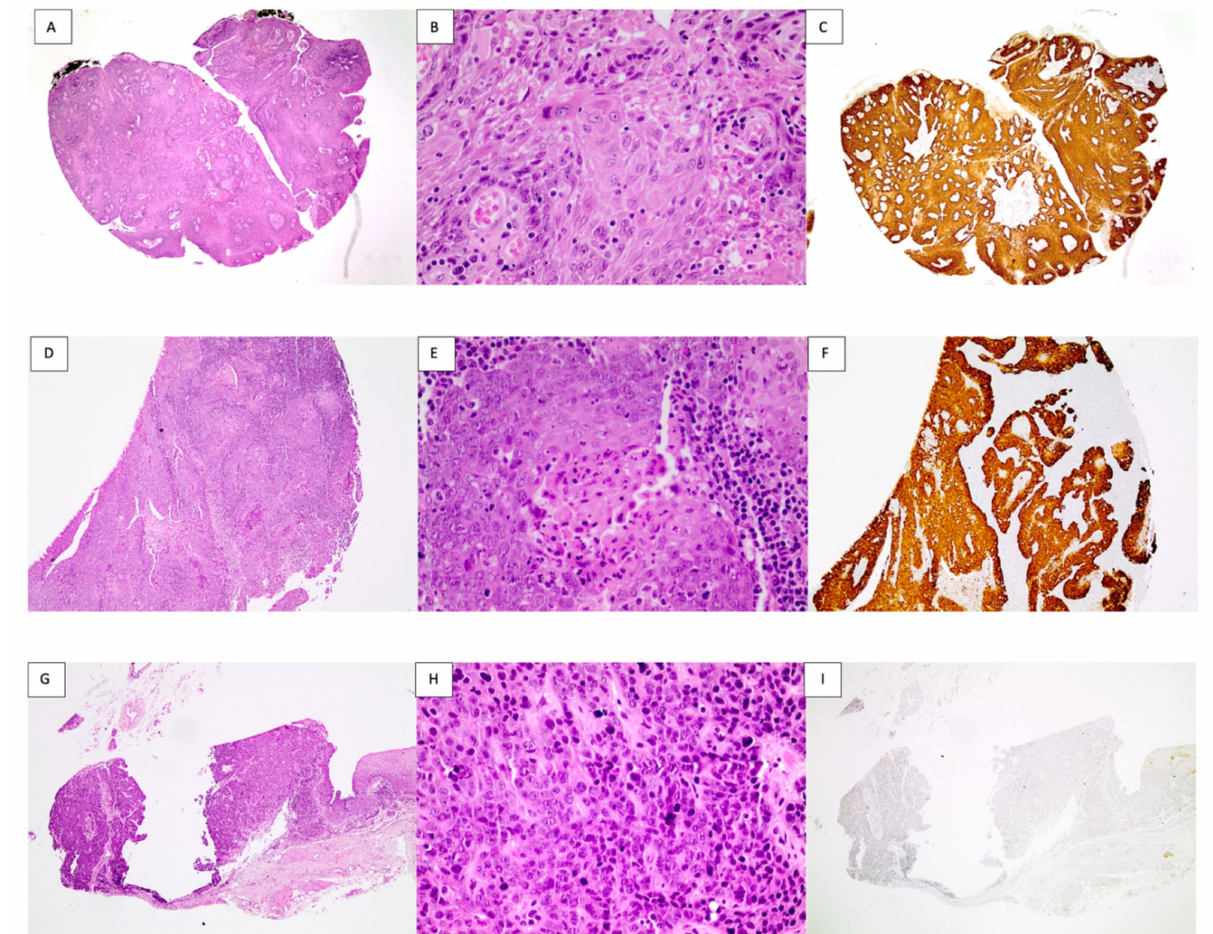
Figure 1. Representative images of the histological sections with hematoxylin–eosin staining and p16 IHC, of base of the tongue, palatine tonsil, and soft palate. ( A – C ): Tongue base squamous cell carcinoma. ( A ). Section with hematoxylin–eosin stain, tissue fragment showing infiltrating squamous cell carcinoma, partially keratinizing. ( B ). Detail of the cytological atypia with pleomorphism, hyperchromasia, and focal keratinization. ( C ). Intense and diffuse cytoplasmic and nuclear positivity for p16 in the neoplastic cells. ( D – F ): Palatine tonsils squamous cell carcinoma. ( D ). Section with hematoxylin–eosin stain, tonsillar tissue with loss of its architecture, and replacement by infiltrating squamous cell carcinoma. ( E ). Tumor nest showing less differentiated population towards the periphery, in the center with keratinization and partial necrosis accompanied by polymorphonuclear cells, lymphoplasmacytic inflammatory infiltrate in the vicinity. ( F ). Intense and diffuse cytoplasmic and nuclear positivity for p16 in the neoplastic cells. ( G – I ): Soft palate squamous cell carcinoma. ( G ). Section with hematoxylin–eosin stain, mucosa of the palate infiltrated by nonkeratinizing squamous cell carcinoma, with a small remnant of normal tissue towards the far right of the image. ( H ). Detail of the cytology with basaloid cells, hyperchromasia, and mitosis, without evidence of keratinization. ( I ). p16-negative specimen by